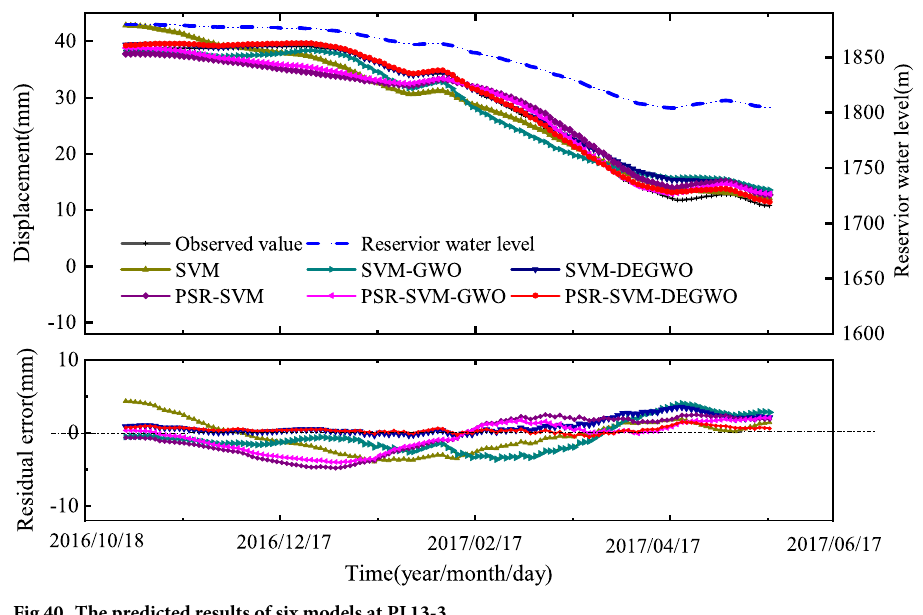
Fig 40. The predicted results of six models at